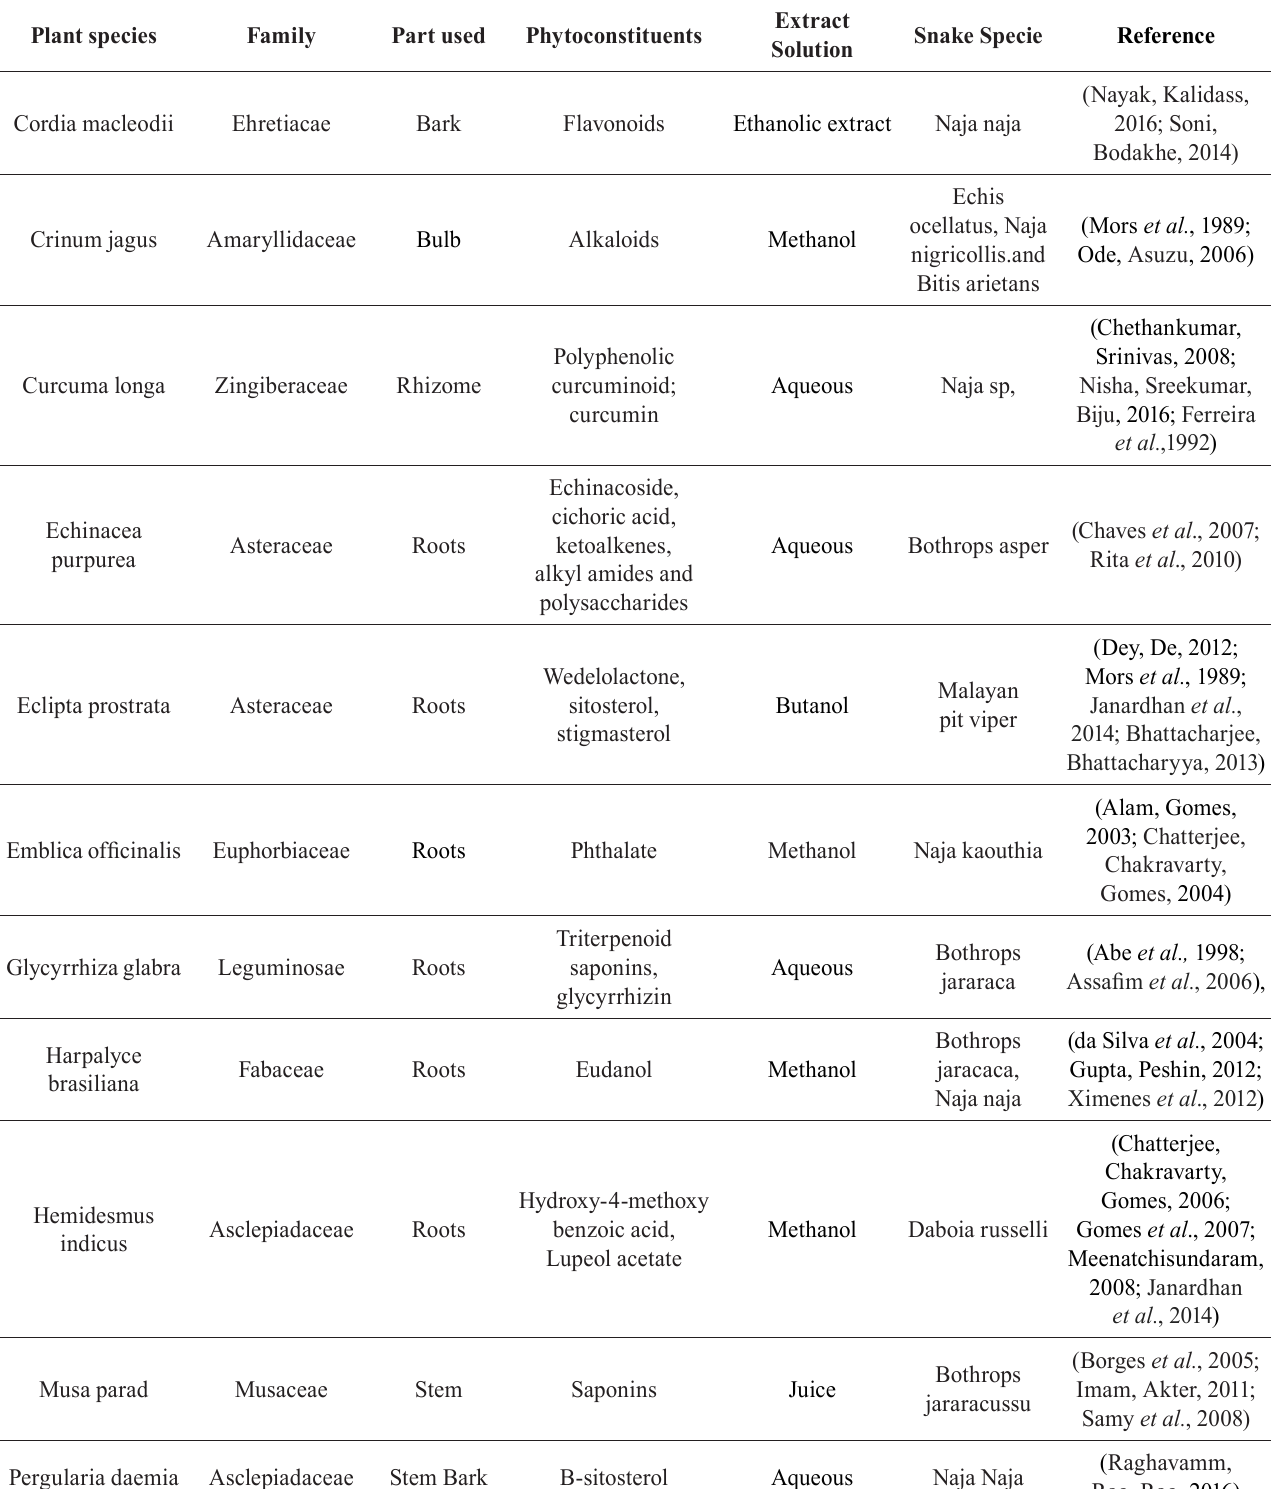
TABLE II - Investigated Medicinal Plans against various Snake